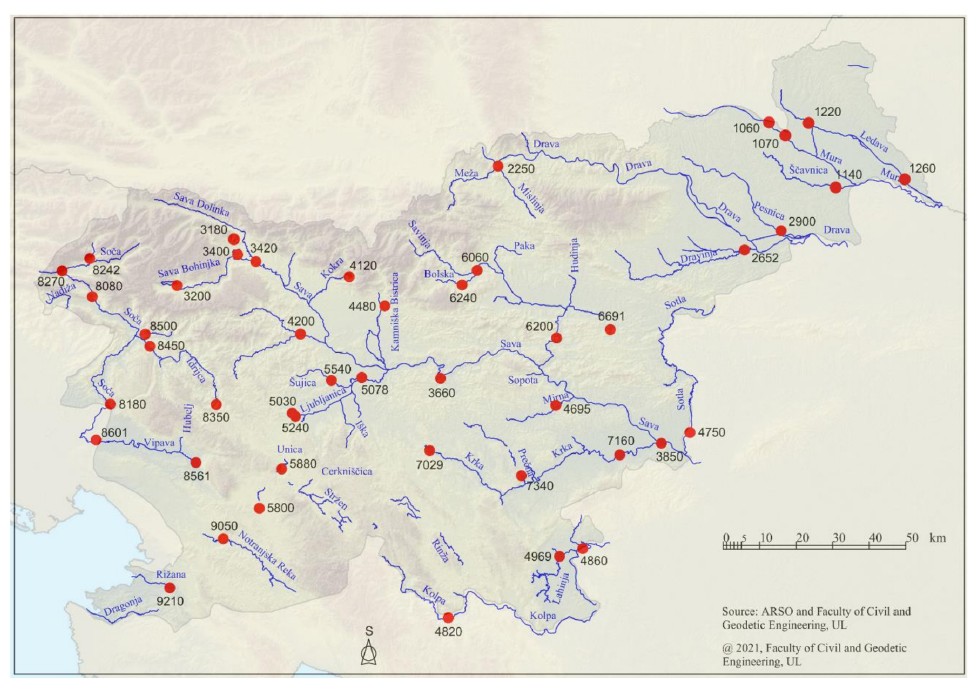
Figure 1. Location of the considered gauging stations on the map of Slovenia.